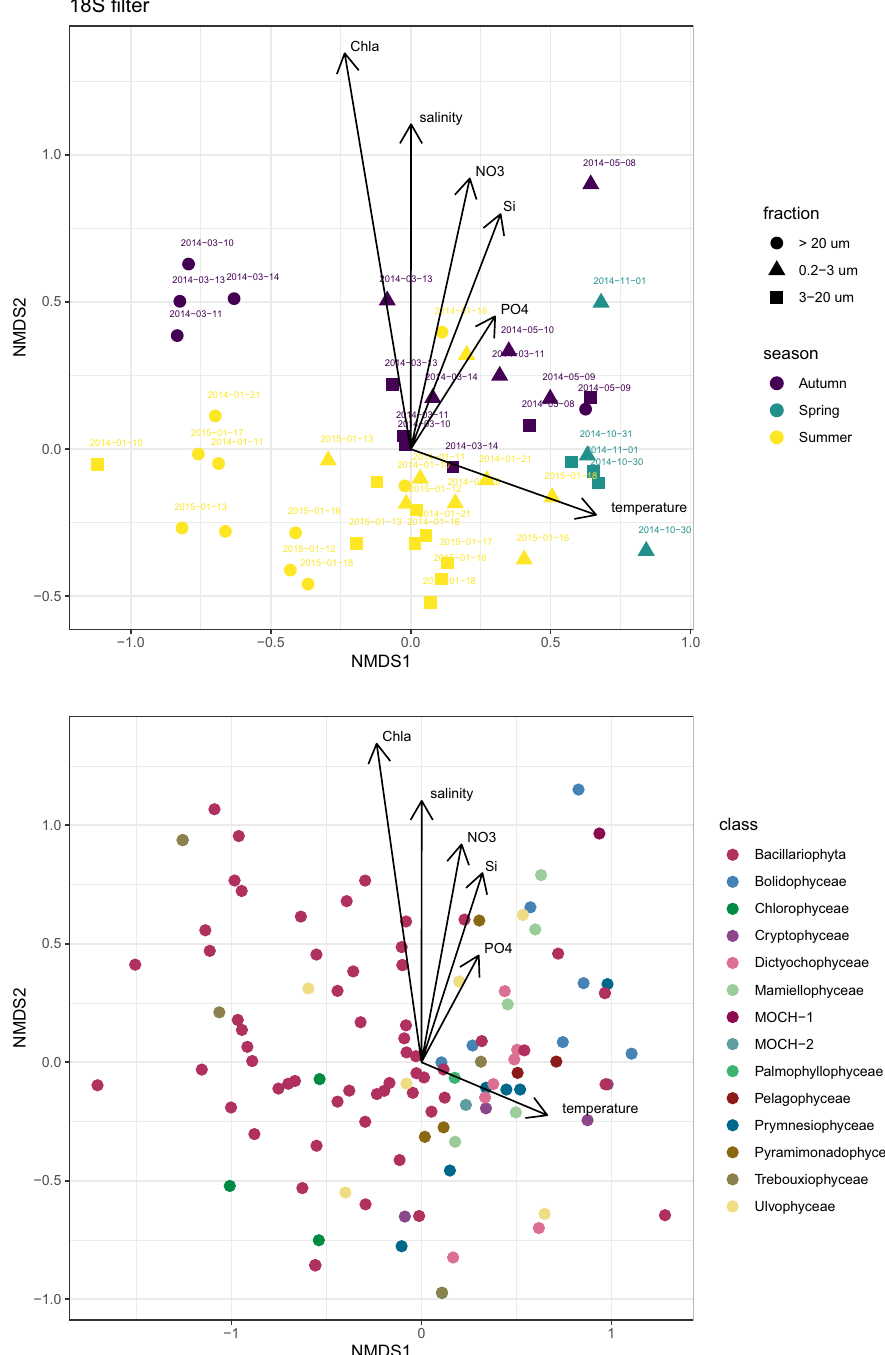
Figure 5. Non-metric multidimensional scaling (NMDS) analysis based on Bray-Curtis dissimilarities of the phytoplankton community composition (species) labeled by meteorological season (summer, autumn, and spring) and size fraction based of the 18S gene of filtered samples. (Top) Samples. (Bottom) ASVs. Stress =